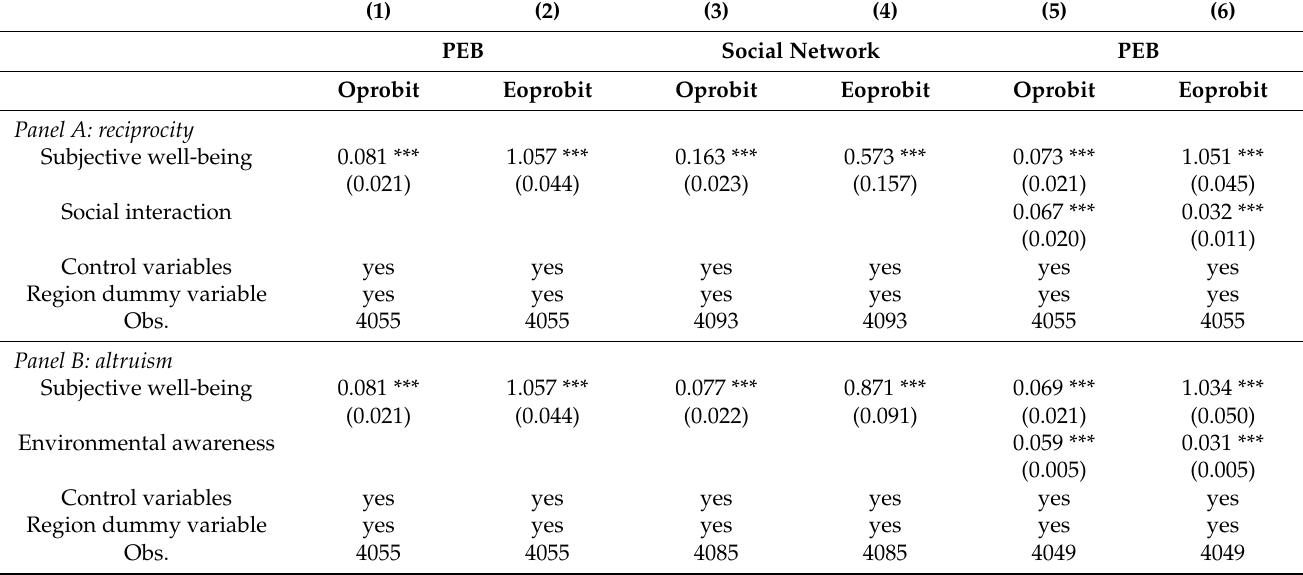
Table 5. The test results of the mechanism (reciprocity) by which subjective well-being influences the PEB of rural